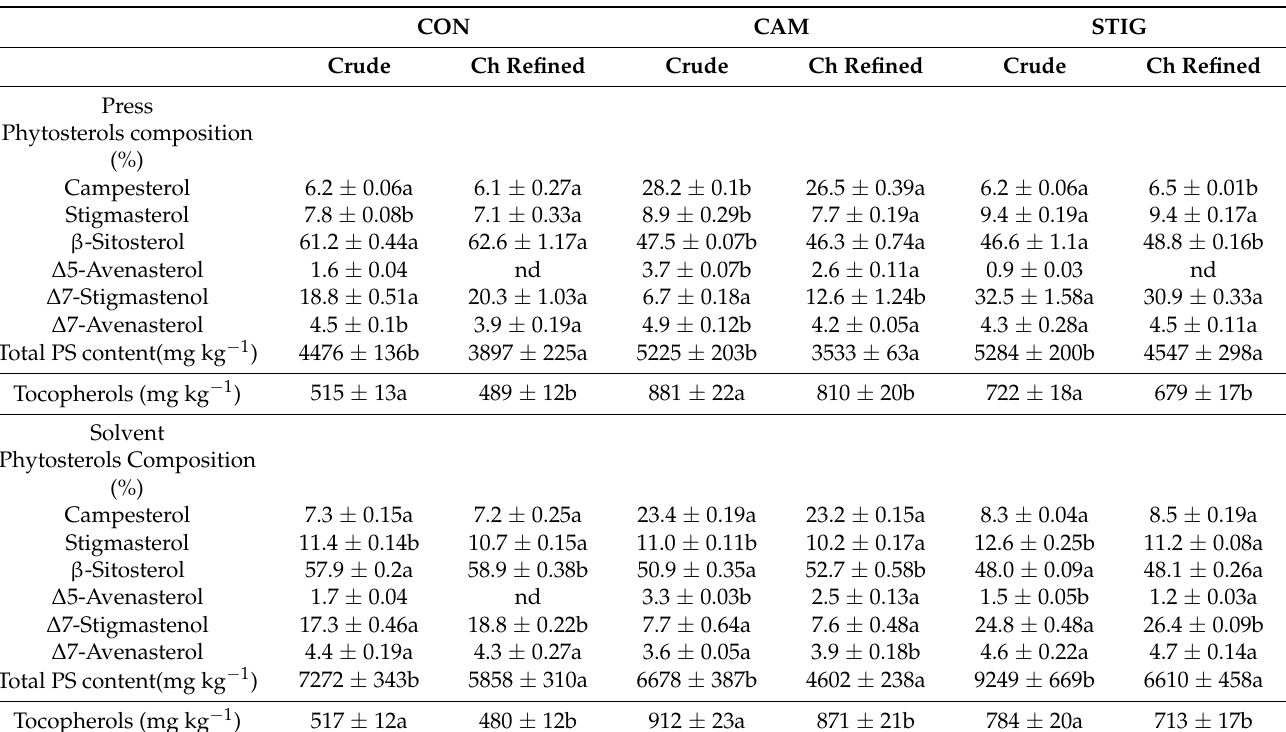
Tocopherols (mg kg − 1 ) nd, not detected. Results for FA and PS are expressed as mean values ± standard deviation ( n = 4 for crude oils and n = 3 for refined oils). Different letters indicate significant differences between crude and refined oils for each sample ( p < 0.05), according to the Student’s t